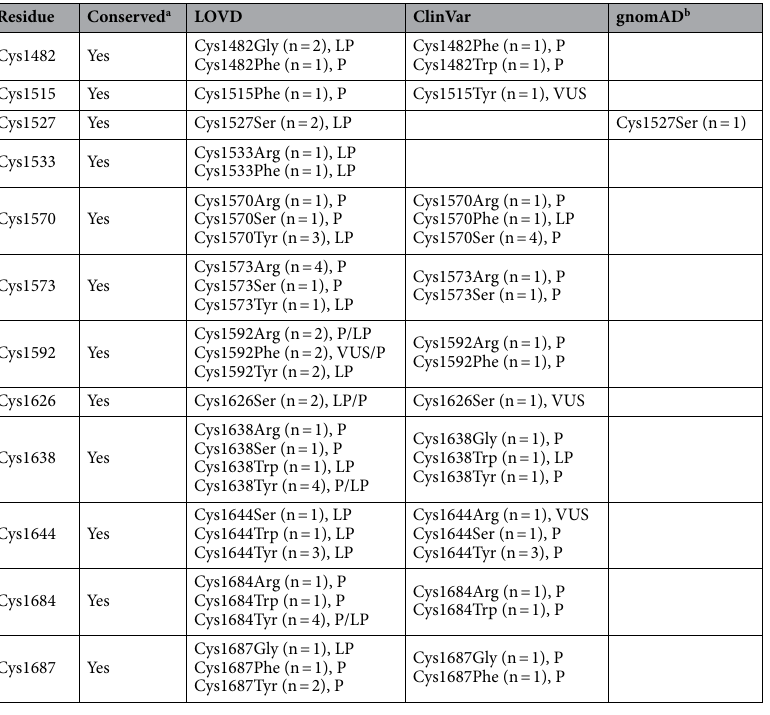
Table 1. Collagen IV α5 Cys residues and missense variants reported in LOVD, ClinVar and gnomAD. No Cys missense variants were found in the 100kGP database. LB, Likely Benign; LP, Likely Pathogenic; P, Pathogenic; VUS, Variant of Uncertain Significance. a Residues fully conserved in all six human collagen IV α-chains. b Independent pathogenicity assessments were not provided by this database.